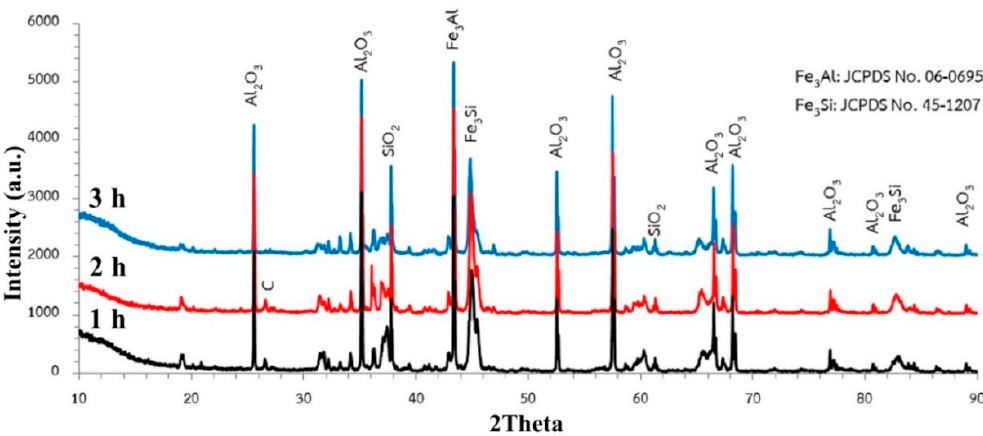
Figure 4. XRD patterns of the pellet (C/O = 1) after heating at 1550 °C for up to 3 h.